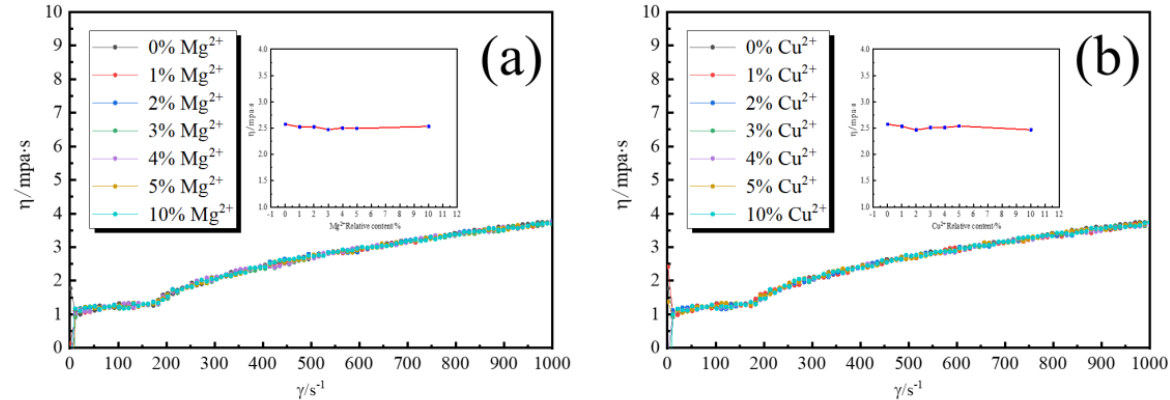
Figure 4. Viscosity of the EPD suspension with different Mg 2+ and Cu 2+ relative content changes with shear rate (inset is the average viscosity with different Mg 2+ and Cu 2+ relative content). ( a ) with Mg 2+ ( b ) with Cu 2+ .